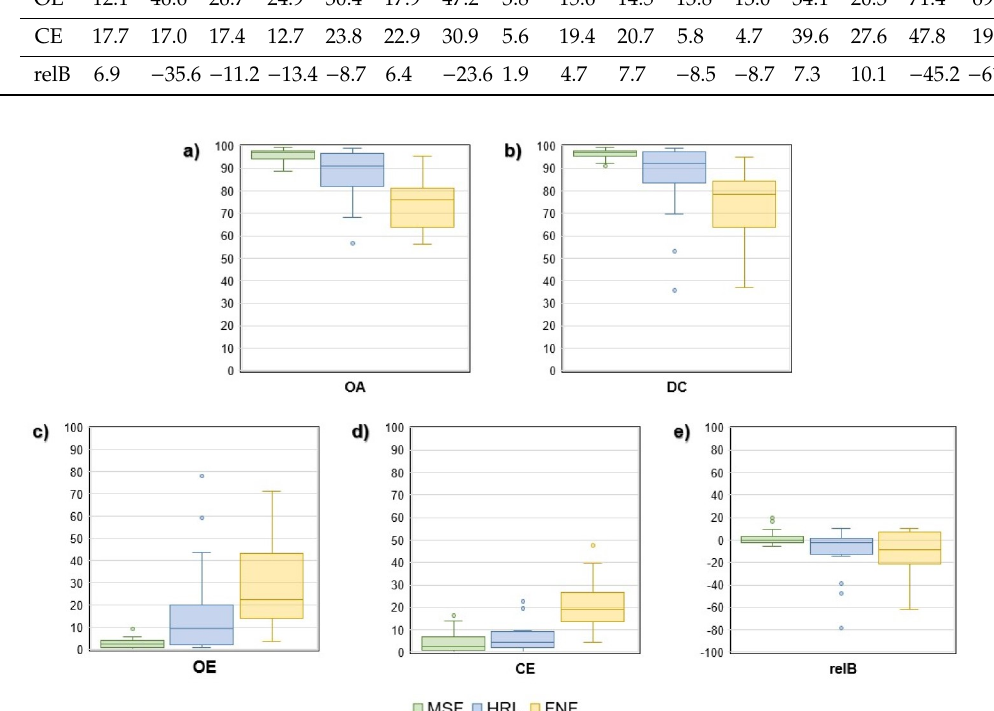
Figure 4. Box plots of performance metrics across the 16 AOIs for the three forest mask products: ( a ) overall accuracy; ( b ) Dice similarity coefficient; ( c ) omission errors; ( d ) commission errors, and ( e ) relative bias.